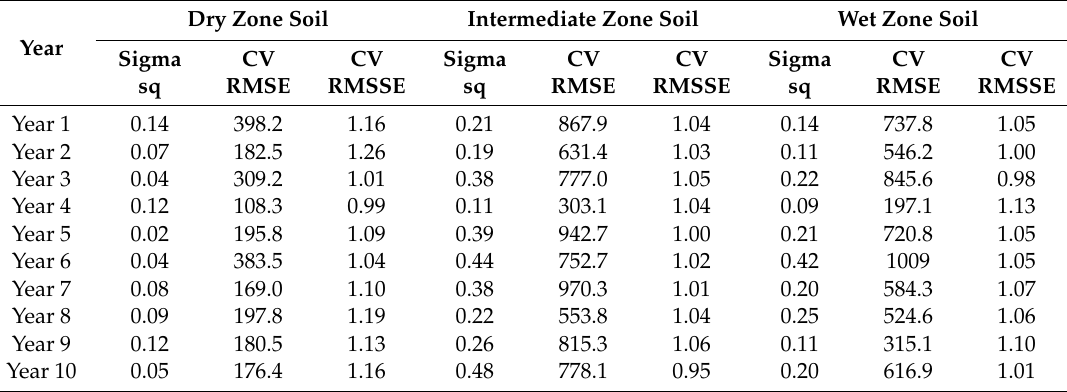
Table A2. The accuracy of the emulators developed to estimate the weight of rough rice (kg / ha) of rice (WRR) for di ff erent environments in Sri